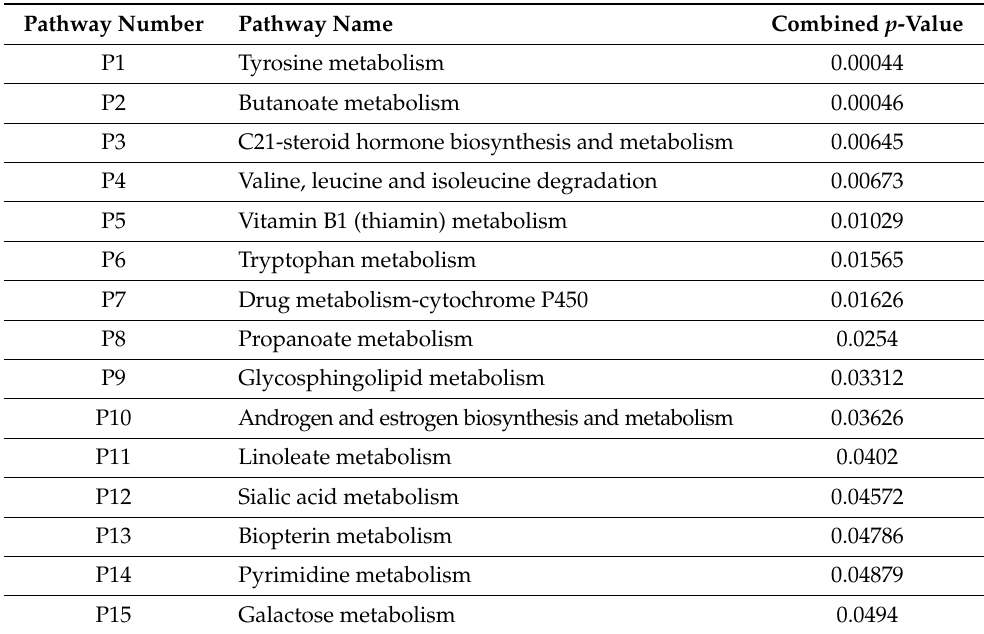
Table 3. Significantly perturbed metabolic pathways that differentiated NIST smokers’ and non- smokers’ reference urine materials.